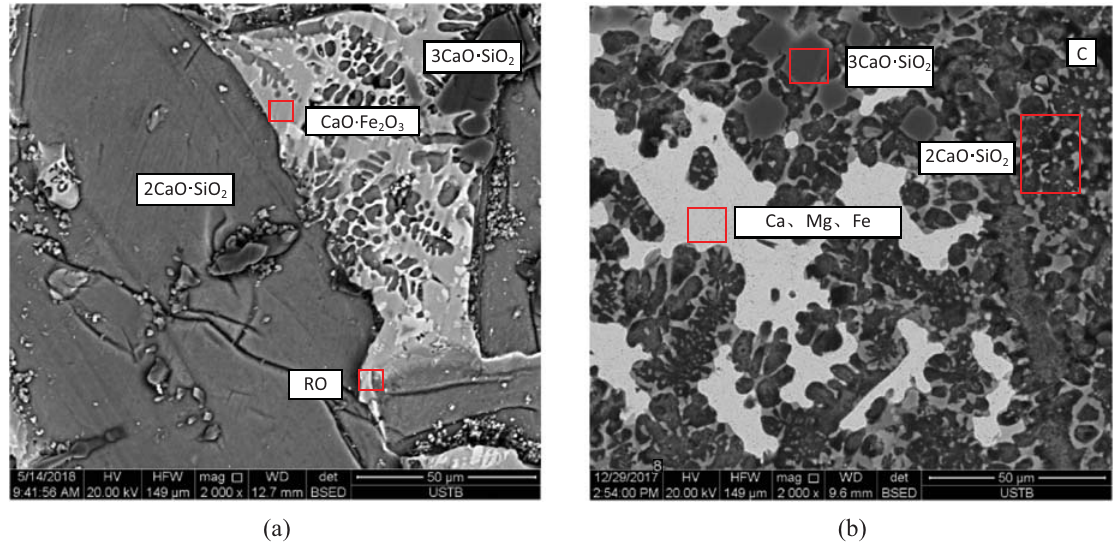
Figure 15: The typical phase of converter slag and gasi fi cation dephosphorization slag. ( a ) Converter slag, ( b ) gasi fi cation dephosphorization